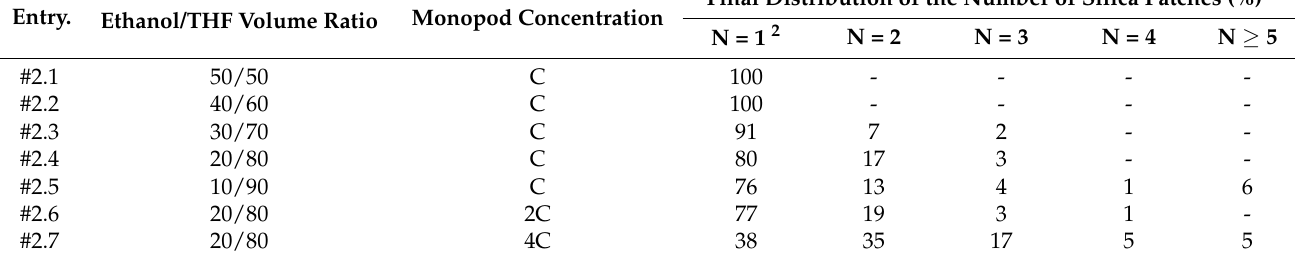
Table 2. Final distribution of the number of silica patches on the PS particles as a function of the composition of the ethanol/THF mixture and the concentration of monopods. Experimental conditions: [monopods] = C = 7.3 × 10 14 part./L at 25 ◦ C for 24 h. Representative TEM images are shown in Figure S2 for entries #2.3 to #2.7.